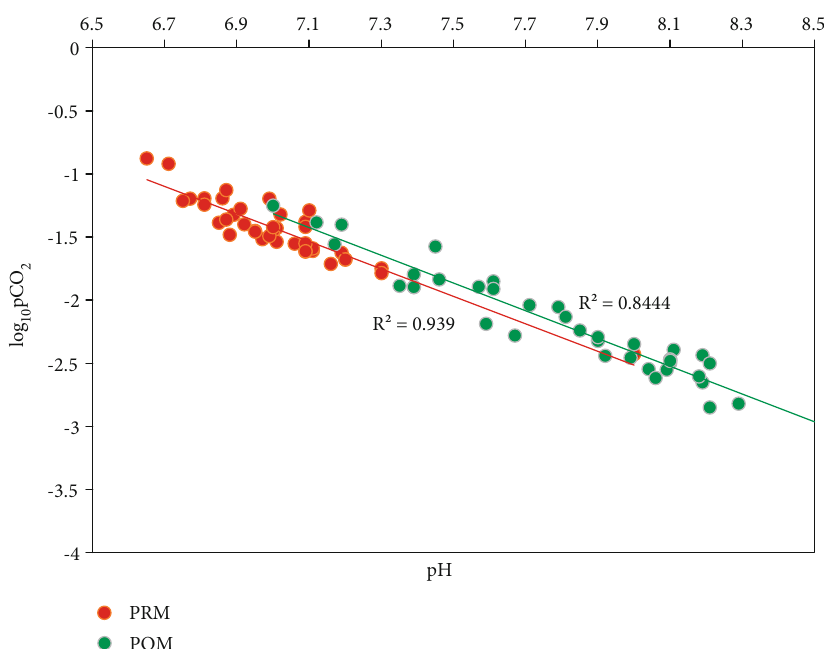
Figure 12: Geochemical relationship of pH vs. log